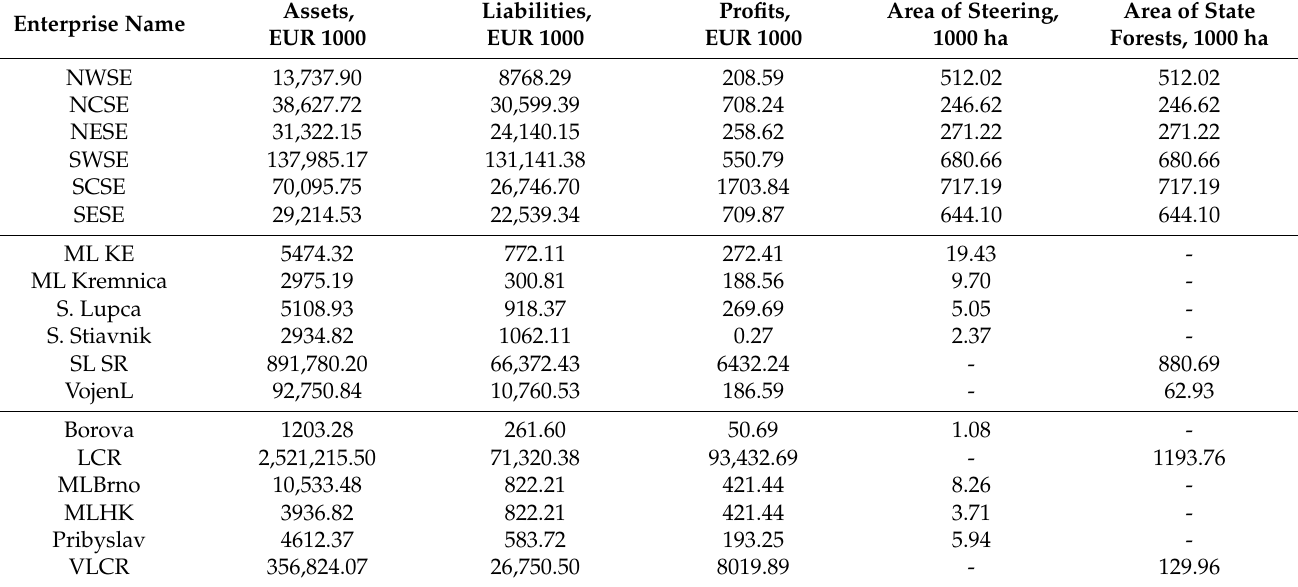
Table 1. General features of the analysed enterprises.